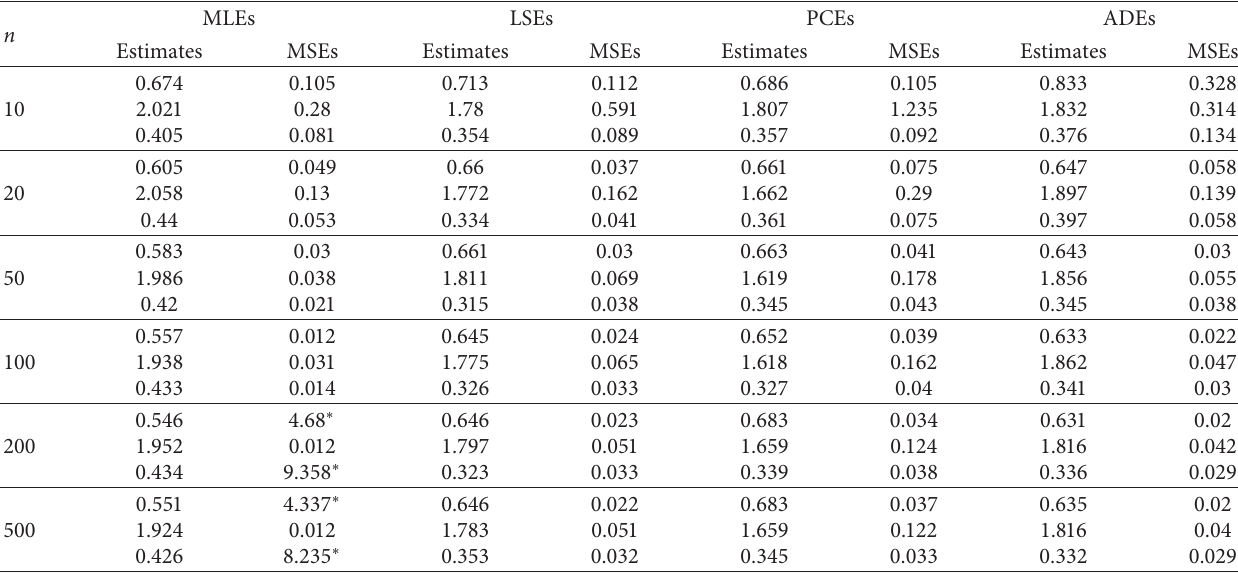
Table 7: Estimates and MSEs of the OFIL distribution for MLEs, LSEs, PCEs, and ADEs for set 6 ( α � 0 . 5 , θ � 2 , and β � 1 . 5). MLEs LSEs PCEs n